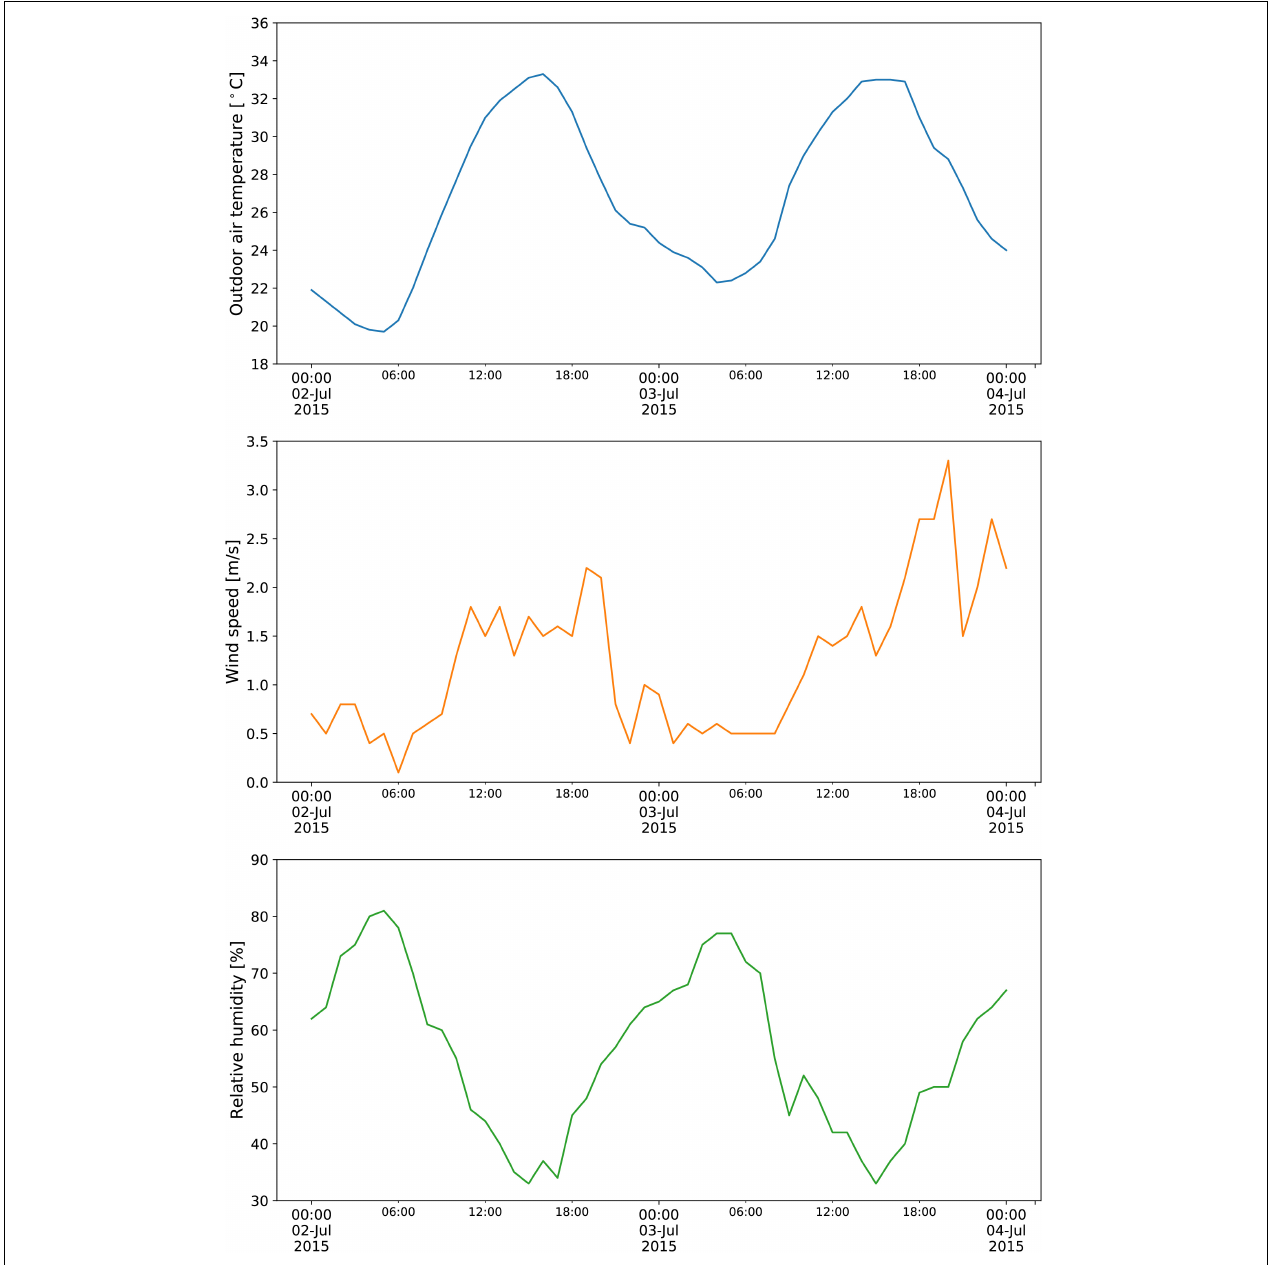
FIGURE 4 | Data from the weather station SMA for the time period under